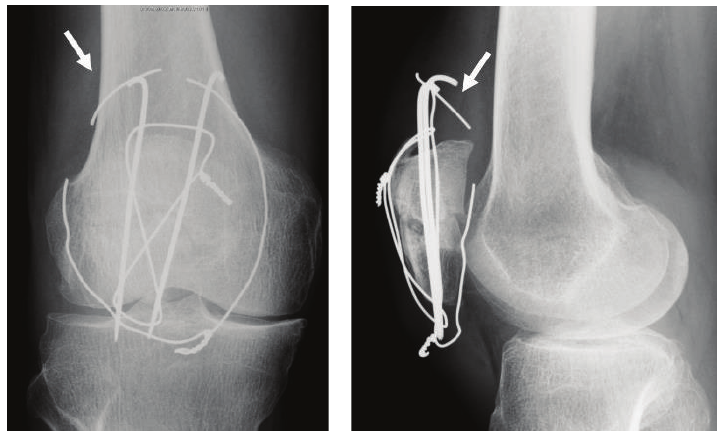
Figure 2: Plain radiographs at 10 weeks postoperatively show breakage of the superior portion of the cerclage wire (arrow).